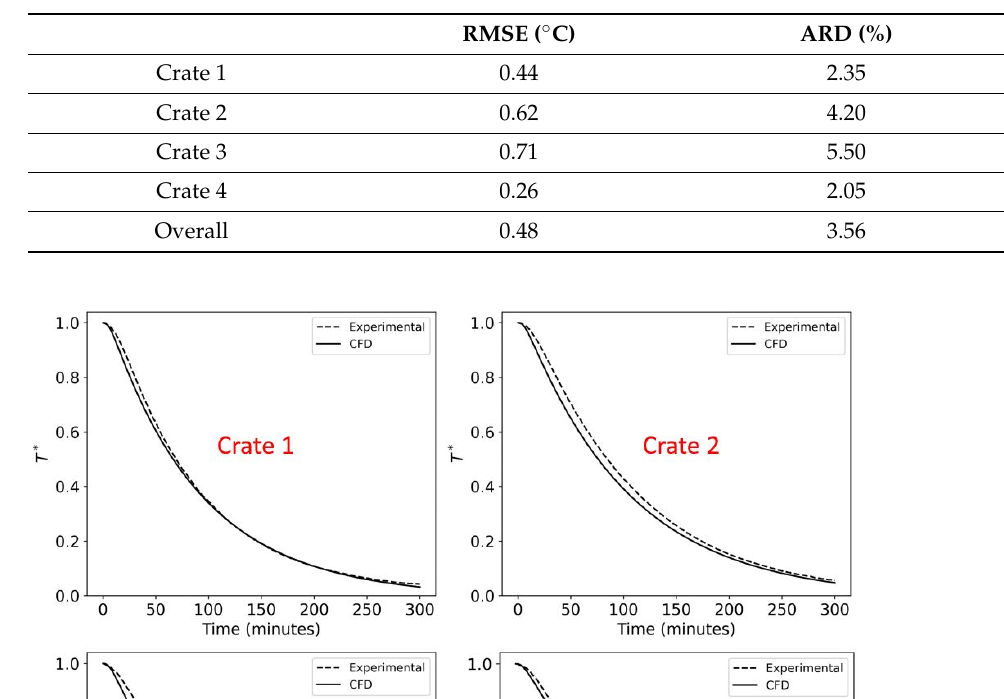
Table 3. Model prediction errors.